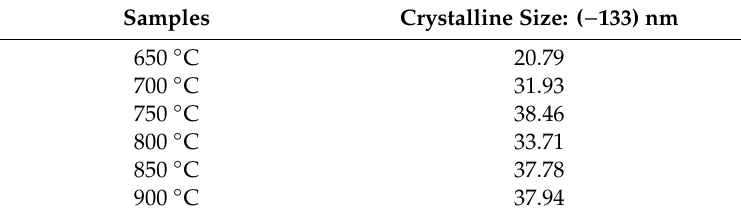
Table 4. Lattice parameters for 1% Ni-doped samples at di ff erent calcination